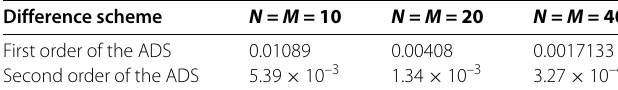
Table 4 Error of v in example (57)